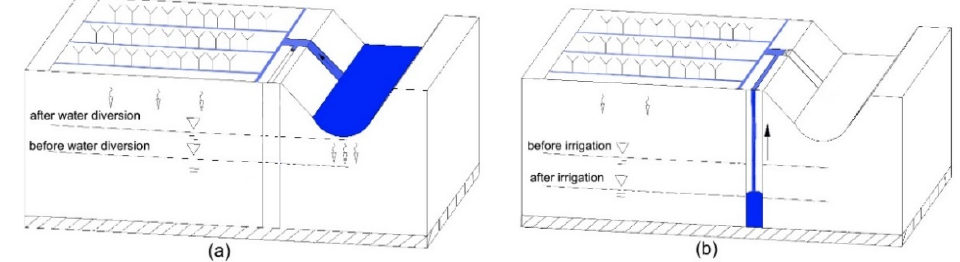
Figure 3. Well–canal combination mode ( a ) with Yellow River water diversion and ( b ) without Yellow River water diversion.